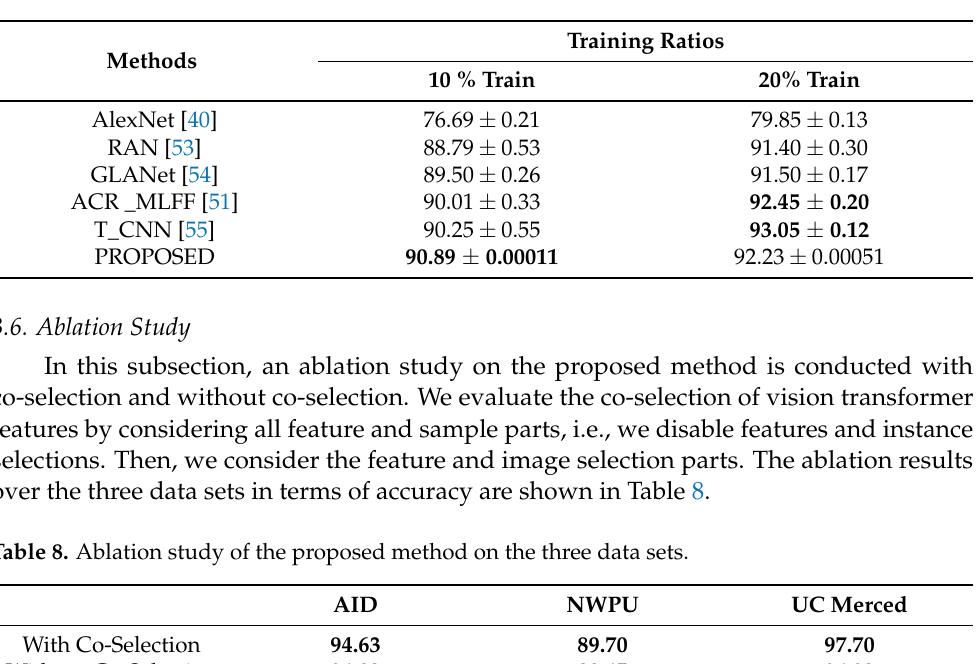
Figure 16. Confusion matrix of our method under the 20% training ratio 90% of features on the NWPU data set. Table 7. Overall accuracy and standard deviatio of the proposed method and comparison approaches on the NWPU-RESISC45 data set.